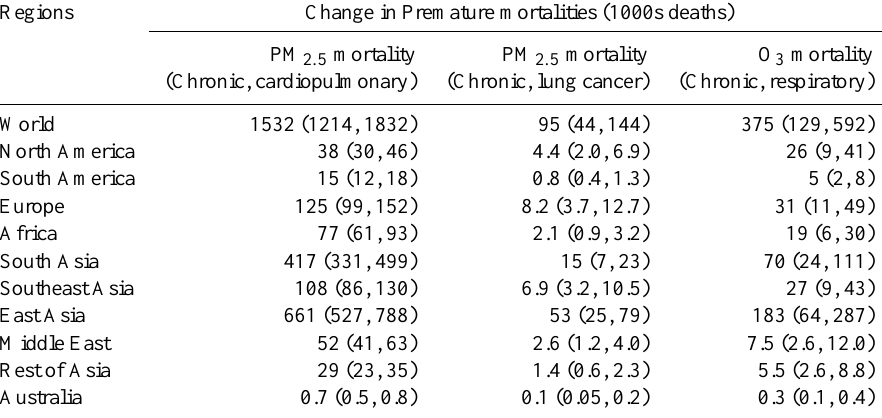
Table 4. Premature mortalities in 2000 associated with industrial air pollution. Values are calculated as in Eq. (1), using ACS health impact functions, concentration difference in annual PM 2 . 5 and H-O 3 between “1860” and “2000” simulations, WHO baseline mortality rate and population in the year 2000. The 95% confidence intervals are shown in